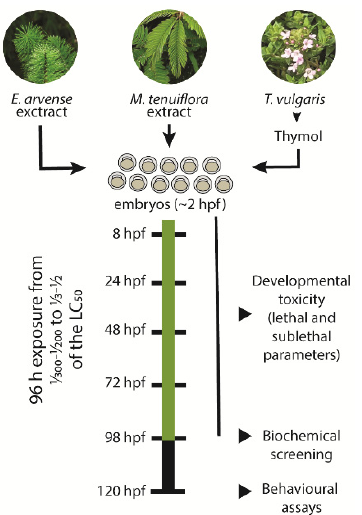
Figure 1. Schematic diagram of the zebrafish exposure to the plant-based fungicides . Collected embryos at around 2 h post-fertilization (hpf) were exposed to different concentrations of Equise- tum arvense and Mimosa tenuiflora extracts and to Thymol for a period of 96 h. The selected concen- trations varied from 1/300–1/200 to 1/3–1/2 of the determined LC 50 . During the exposure period, daily lethal and sublethal parameters were assessed. After 96 h exposure, eleutheroembryo were collected for biochemical screening of different biomarkers associated with oxidative stress, ener- getic metabolism, and neurotransmission. At 120 hpf, the locomotor activity of the eleutheroem- bryo was assessed using different behavioural